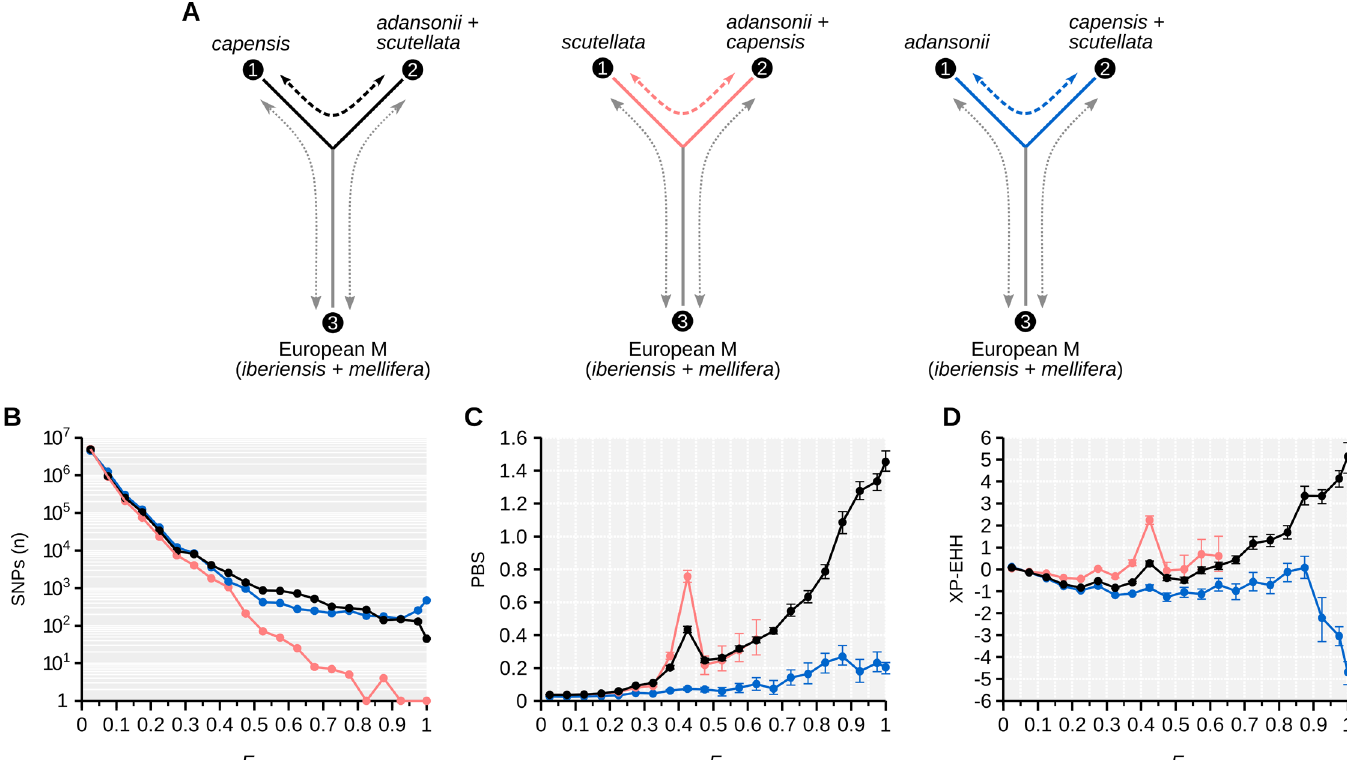
Fig 2. Selection signals are stronger in the Cape bees than any of the other two subspecies. The fixation index ( F ST ), Population Branch Statistic (PBS) and Cross-Population Extended Haplotype Homozygosity (XP-EHH) were computed for every SNP segregating between each African subspecies and a combined population consisting of the two remaining subspecies. (A) The structure of the three experiments. The main F ST value was computed between each subspecies and the combined population (dashed line; population 1 (n = 10) and 2 (n = 20); F ST1 ! 2 ) for every SNP. F ST1 ! 2 was also estimated across 1kbp windows and between each population and a distantly related European outgroup (grey dashed lines; F ST1 ! 3 and F ST2 ! 3 ) in order to estimate the local PBS associated with every SNP. The first figure represents the main scan, i.e. comparing the Cape bees against the other African and European bees (black). The middle figure compares scutellata against the other bees (pink). The last figure compares adansonii against the other bees (blue). (B) The number of SNPs counted for F ST bins of 0.05 for each comparison. Colors as in (A). (C) The mean PBS value for every F ST bin of 0.05. Positive values identify divergence associated with population 1. Outlier variants with F ST > 0.8 are most strongly biased towards divergence in population 1 when the Cape bees are taken as this population. 95% confidence intervals were computed from 200 bootstrap replicates. Colors as in (A). Data points and confidence intervals plotted for bins with at least 10 SNPs. (D) The mean XP-EHH value for every F ST bin of 0.05. Positive values identify long haplotypes in population 1 relative to population 2, whereas negative values represent the opposite. Outlier variants with F ST > 0.8 are most strongly biased towards long haplotypes in population 1 when the Cape bees are taken as this population. 95% confidence intervals were computed from 200 bootstrap replicates. Colors as in (A). Data points and confidence intervals plotted for bins with at least 10